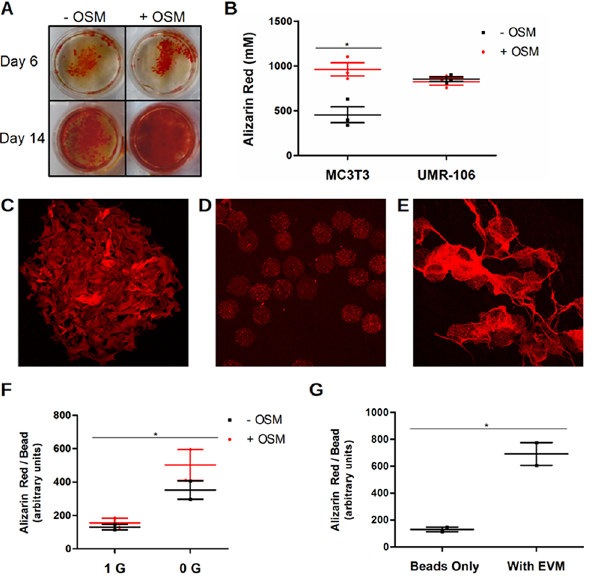
Fig 6. Limitations associated with using this RCCS and Cytopore cell culture model to measure the effects of microgravity on osteoid formation and mineralization. (A) Alizarin red staining of osteoid mineralization after culture of MC3T3-E1 cells for 6 or 14 days in mineralizing culture medium. OSM increases production of mineralizing osteoid. (B) Quantification of the differential effect of OSM on mineralization after 14 d in monolayer culture for the MC3T3-E1 mouse pre-osteoblast and UMR-106 rat osteosarcoma cell lines. (C) Confocal micrograph (400x) of fluorescent alizarin red bound to mineralization in MC3T3-E1 culture on Cytopore microcarriers for 14 d. (D) Representative confocal micrograph (50x) of MC3T3-E1 cultured 14 d on Cytopore with mineralization stained for quantification by densitometry. (E) Confocal micrograph (50x) of Cytopore MC3T3-E1 culture in control gravity conditions showing mineralized osteoid. (F) Densitometry showed greater mineralization in RCCS cultures. (G) Mineralized osteoid accounts for the majority of mineralization under control gravity